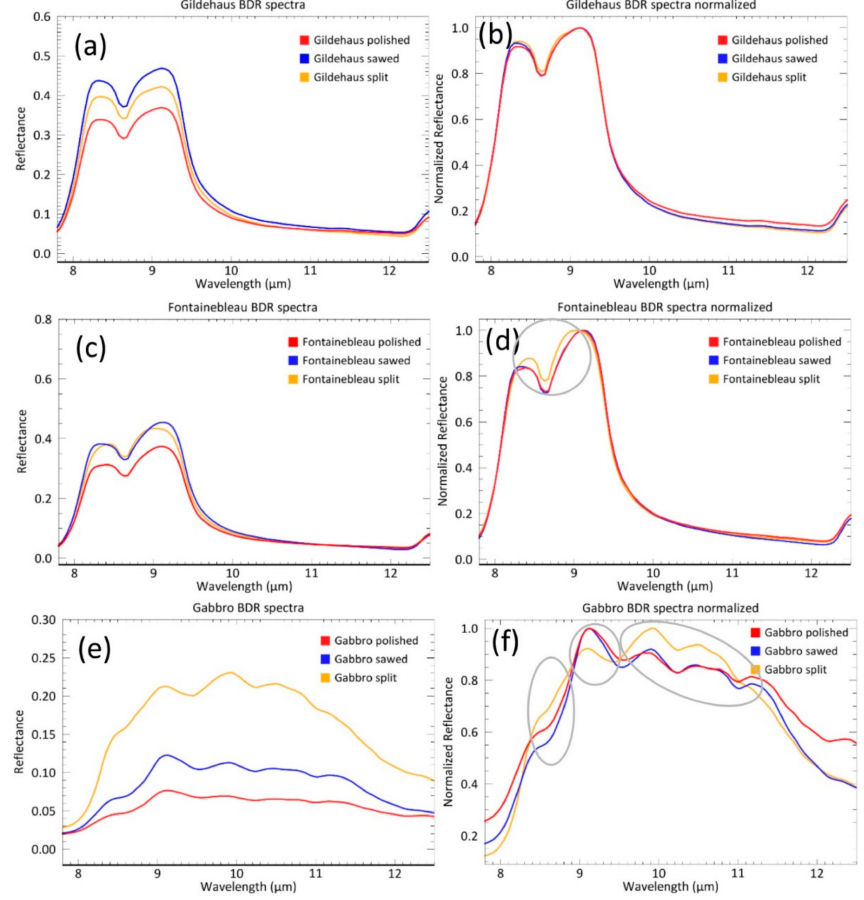
Figure 5. Mean reflectance spectra and normalized mean reflectance spectra of the Gildehaus ( a , b ),